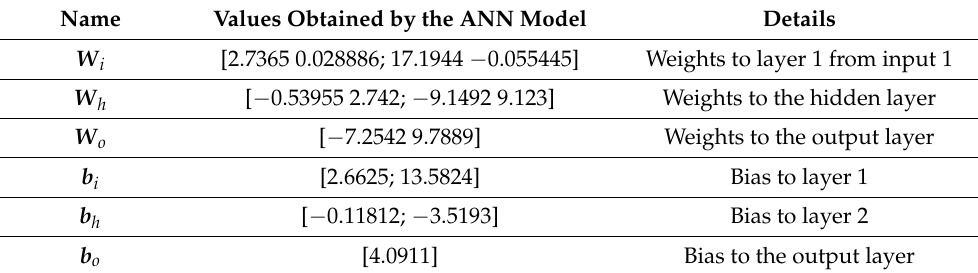
Table 6. Values of weights and biases for the neural network model of the vibration generator.